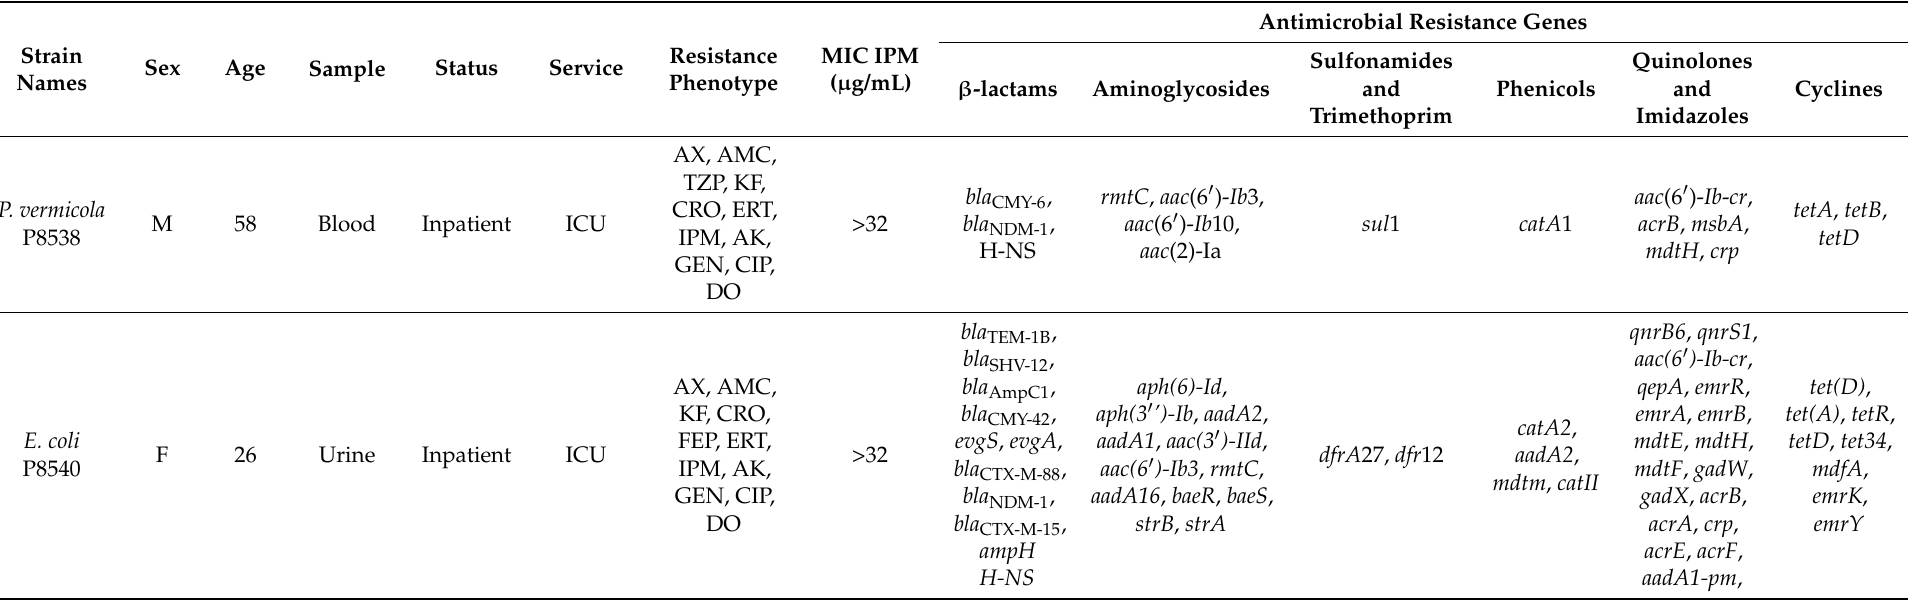
Table 1. Clinical features, Resistance phenotype, and genotype of P. vermicola P8538 and E. coli P8540 harboring the bla NDM-1